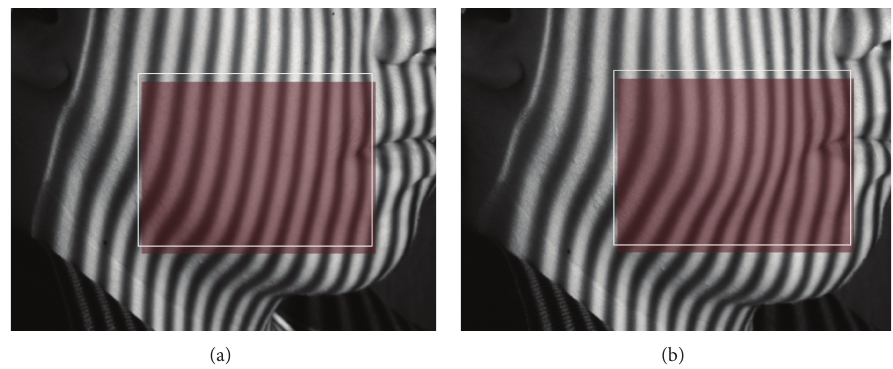
Figure 26: (a) Reference face. (b) Maximum inflammation fringe projections.